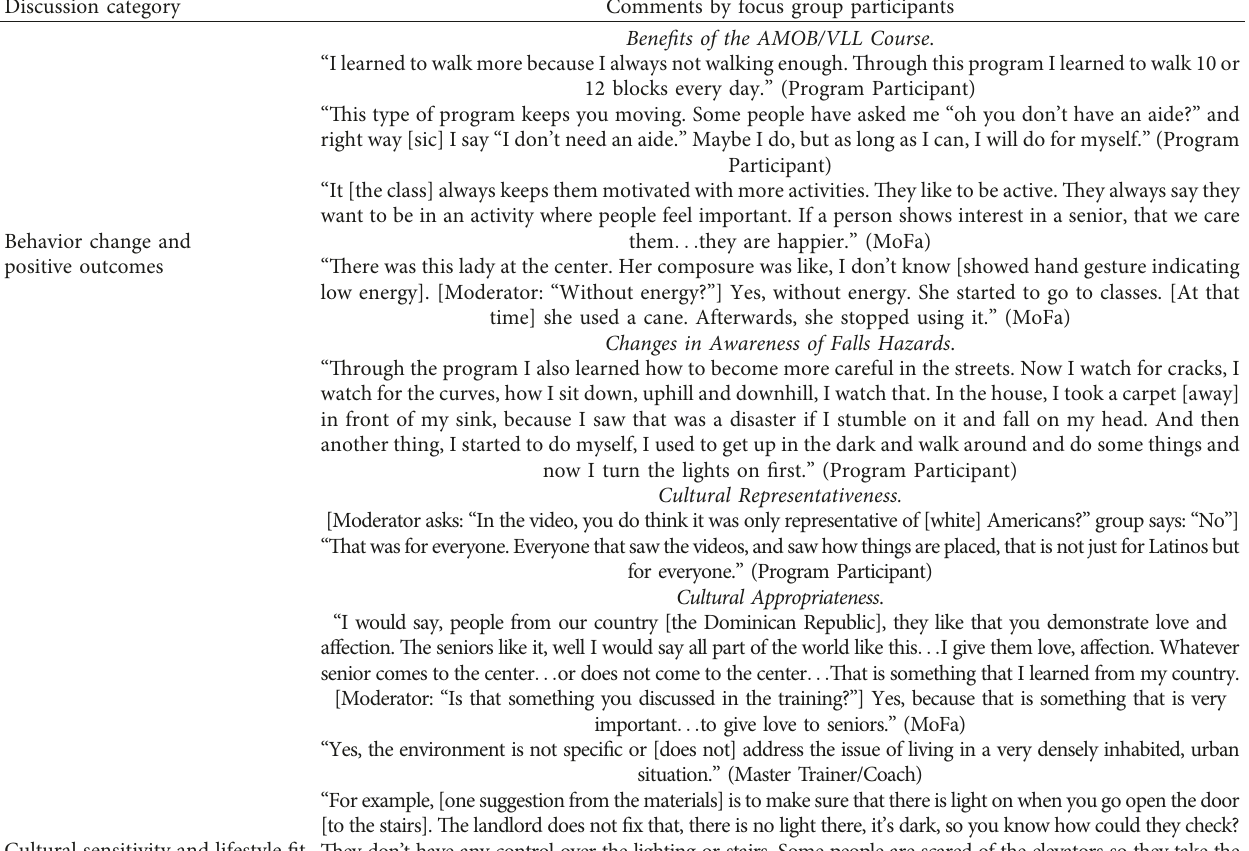
Table 3: Notable comments made by focus group participants for each discussion